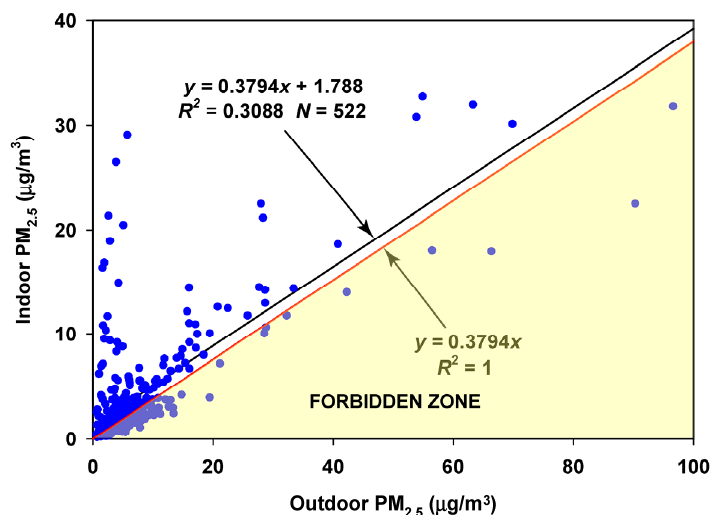
Figure 12. RCS regression of indoor values at Oakmont on outdoor values at Bennett Valley, about 4 km from Oakmont.